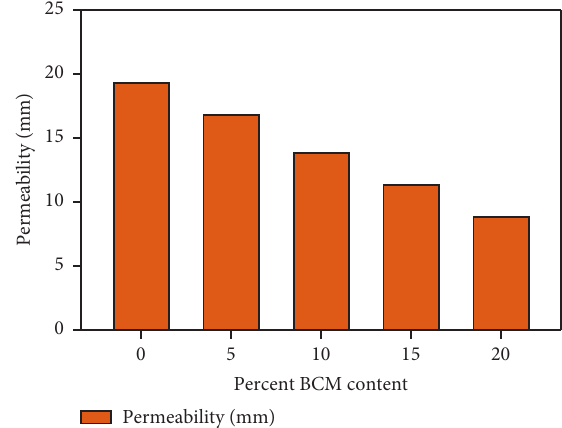
Figure 6: Permeability of concrete containing BCM after 28 days.